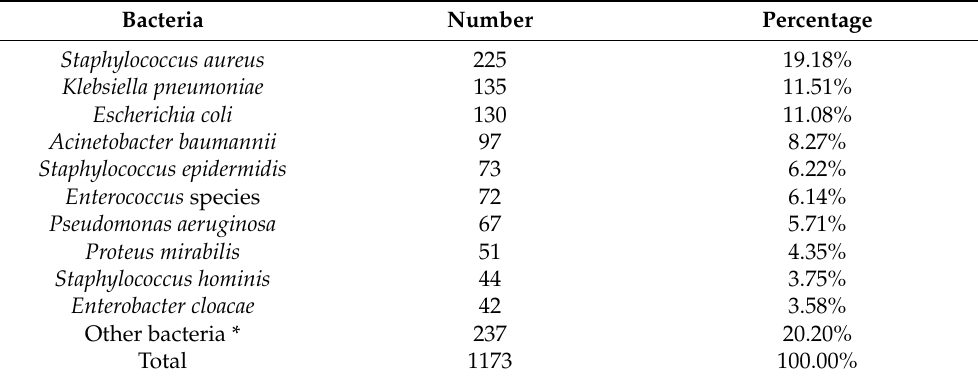
Table 2. The most prevalent bacteria in patients aged between 48 and 63